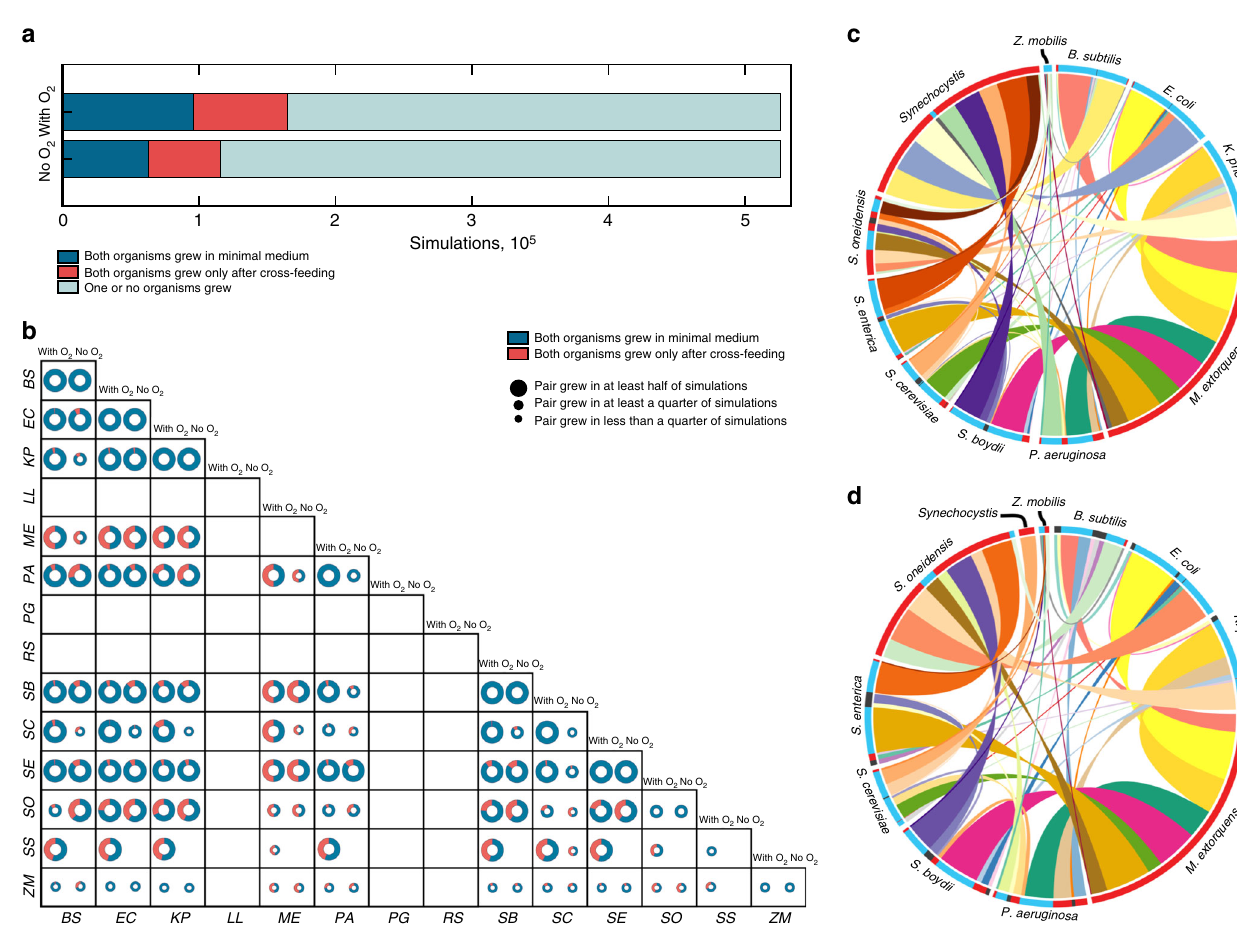
Fig. 4 Growth outcomes of pairwise cross-feeding simulations. a Growth outcomes of all in silico experiments with and without oxygen, grouped by pairwise growth phenotype. b Organism-speci fi c growth outcomes. Size of circles represent the relative number of environments in which an organism was able to grow out of 5774 in silico experiments with each partner. c , d Frequency of obligate pairwise growth by species in single carbon source simulations for oxic ( N = 69,420, c ) and anoxic ( N = 52,897, d ) conditions. Each color ribbon is unique to an individual species pair. Width of ribbons is proportional to the number of experiments in which obligate syntrophy was predicted for each species pair. Radial axis colors represent directionality of exchange: blue: organism provided essential metabolites to partner organism in over 75% of simulations; red: organism received essential metabolites in over 75% of simulations; gray: both organisms gave and received essential nutrients in most simulations. Most pairings of organisms were imbalanced, with one organism more frequently providing essential nutrients to another. For example, with oxygen, Synechocystis relied on metabolites from nine different organisms across the vast majority of simulations in which it grew with a partner. As all organisms were grown heterotrophically, carbon dioxide and ammonium were the main byproducts that enabled growth of Synechocystis in these simulations. BS : B. subtilis , EC : E. coli , KP : K. pneumoniae , LL : L. lactis , ME